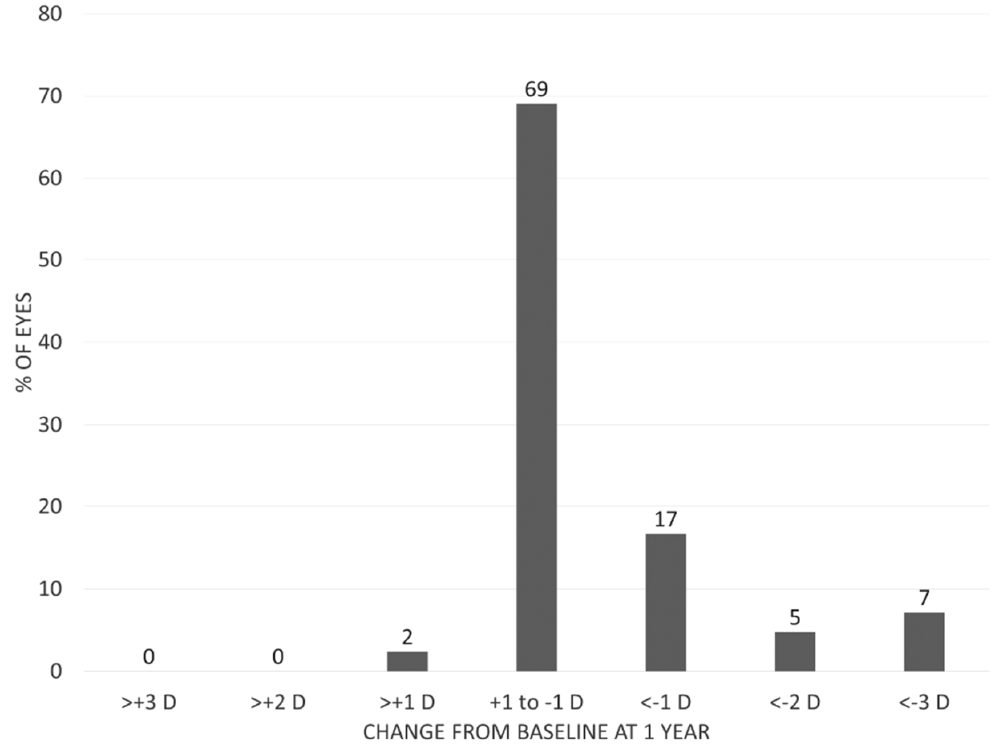
Figure 4. Distribution in changes in Kmax from preoperative values at 1-year post-procedure. Average mean keratometry (Km) was 50.62 ± 6.92 D, 50.22 ± 6.61 D, and 50.04 ± 6.69 D at